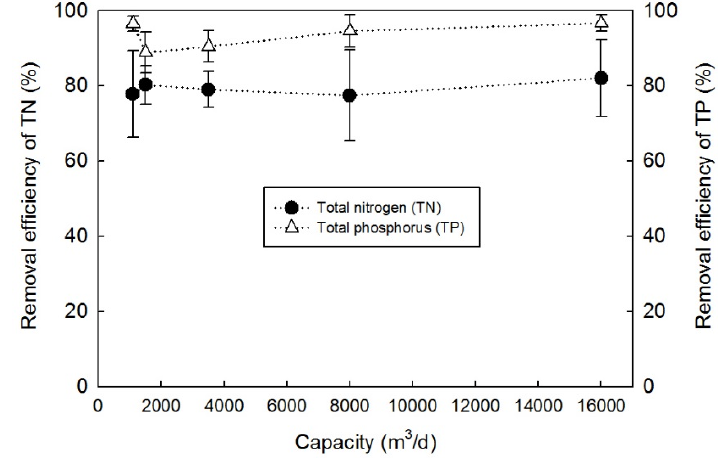
Figure 2. Average removal efficiencies of total nitrogen ( TN ) and total phosphorus ( TP ) by the full-scale DMBR TM systems (Data obtained from the full-scale DMBR TM systems for 1–5 years depending on operation period of each